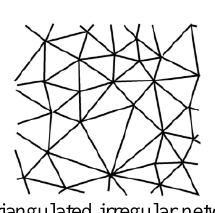
Figure 2. Regular square grid model